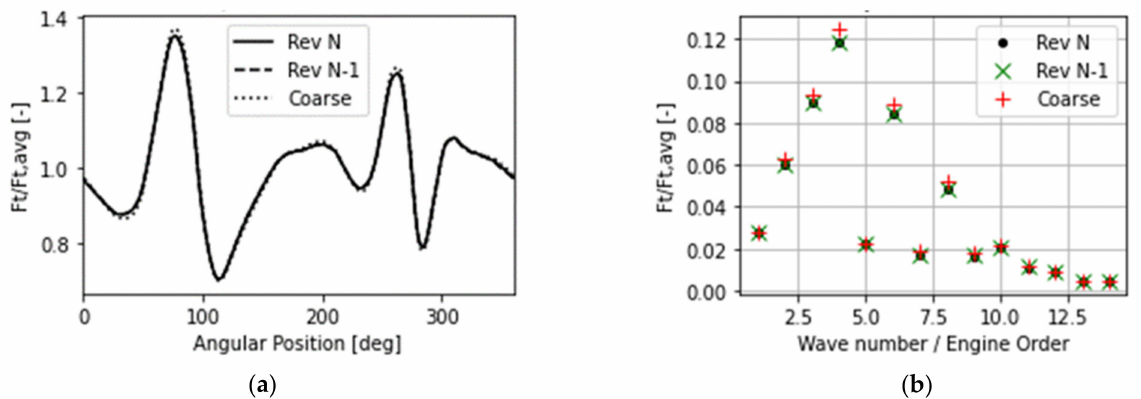
Figure 5. Comparing effects of two consecutive cycles and the effect of mesh size. ( a ) On the force as function of time; ( b ) on the force per wave